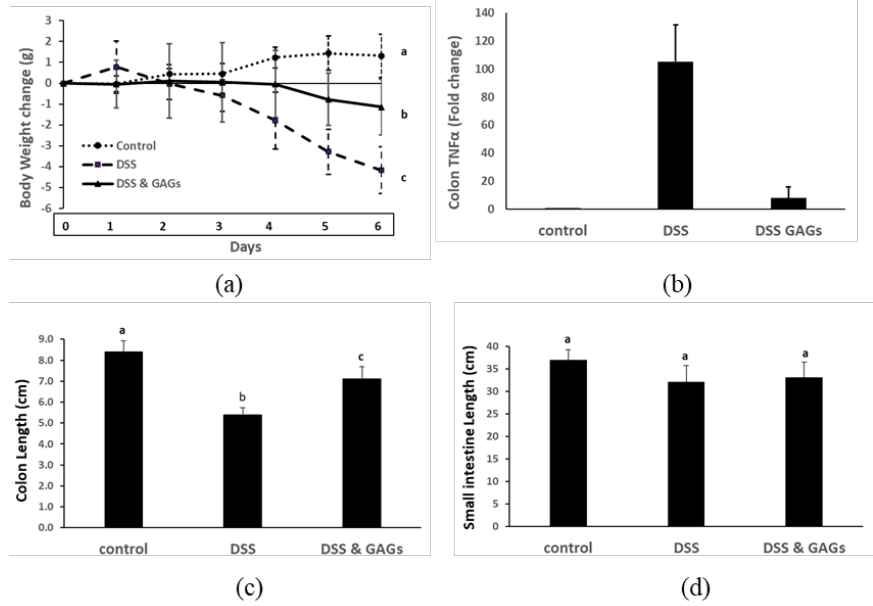
Figure 6. Orally-administered GAGs from sea cucumber ( I. badionotus ) body wall exert anti-inflammatory effects on Dextran sodium Sulfate (DSS)-colitis in mice. DSS (25 g / L in drinking water) was offered mice for four days, followed by water alone for two days. A proportion of the mice were dosed daily with GAGS (80 mg / kg body weight (BW) / d) for one day prior to and during the experimental period. ( a ) Weight change in mice dosed with DSS ± co-treatment with GAGs. ( b ) Colonic TNF α gene expression in mice dosed with DSS ± co-treatment with GAGs. ( c ) Colon lengths in mice dosed with DSS ± co-treatment with GAGs. ( d ) Small intestine lengths in mice dosed with DSS ± co-treatment with GAGs. For each figure, n ≥ 4 per group and values with distinct superscripts differ significantly from each other ( p ≤